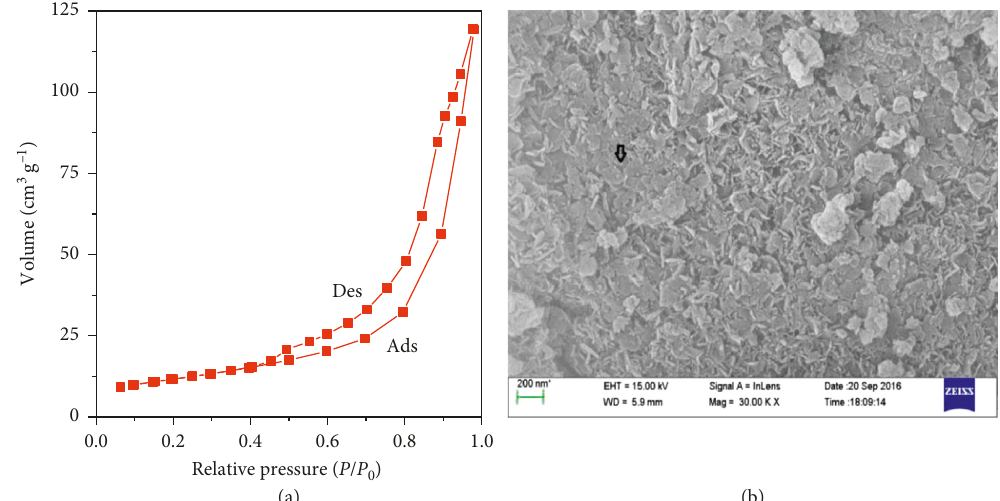
Figure 4: (a) N 2 adsorption-desorption curves of calcinated Cu/Zn/Al-HTlc and (b) SEM images of typical platelet-like Cu/Zn/Al-HTlc.